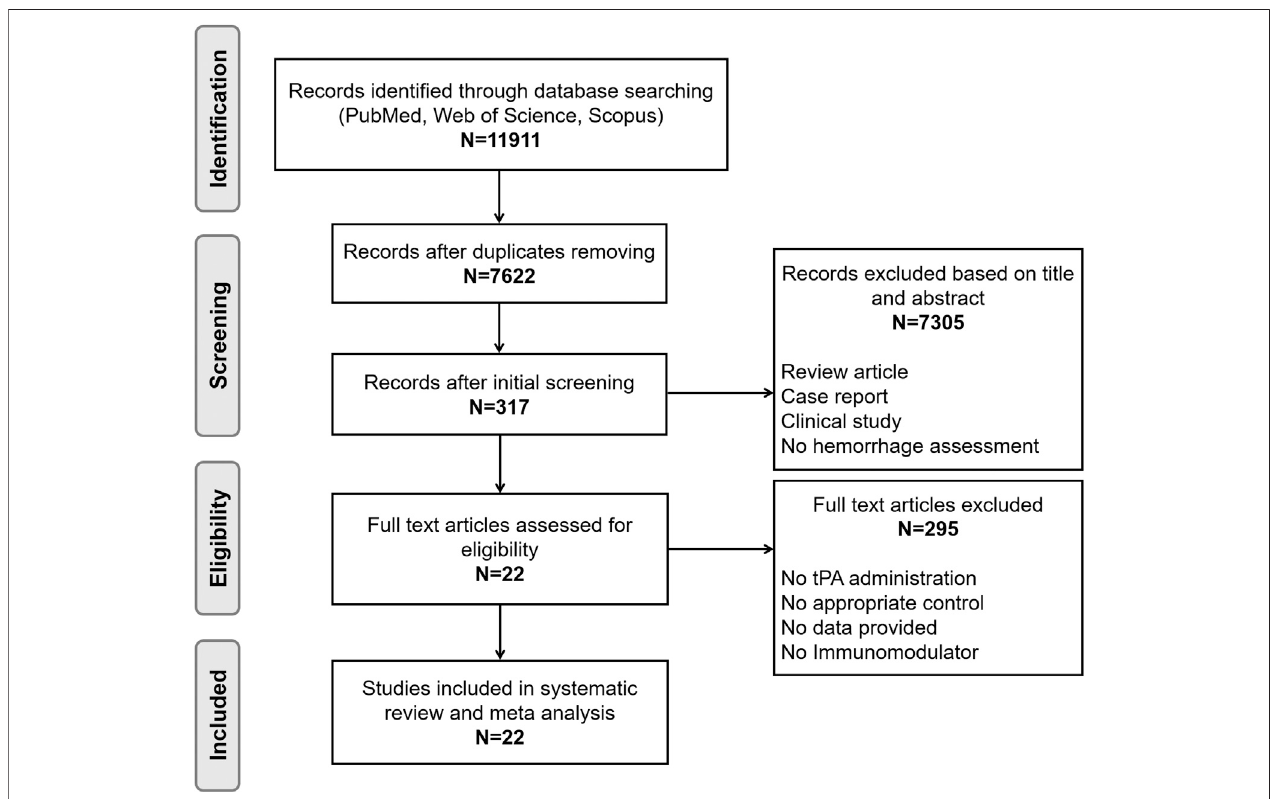
FIGURE 1 | Flow diagram of the study selection